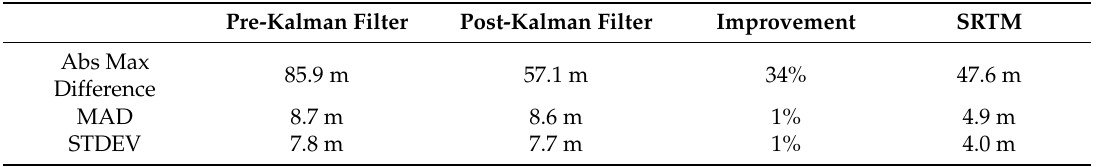
Table 4. Statistical evaluation of elevation differences in respect to the photogrammetric